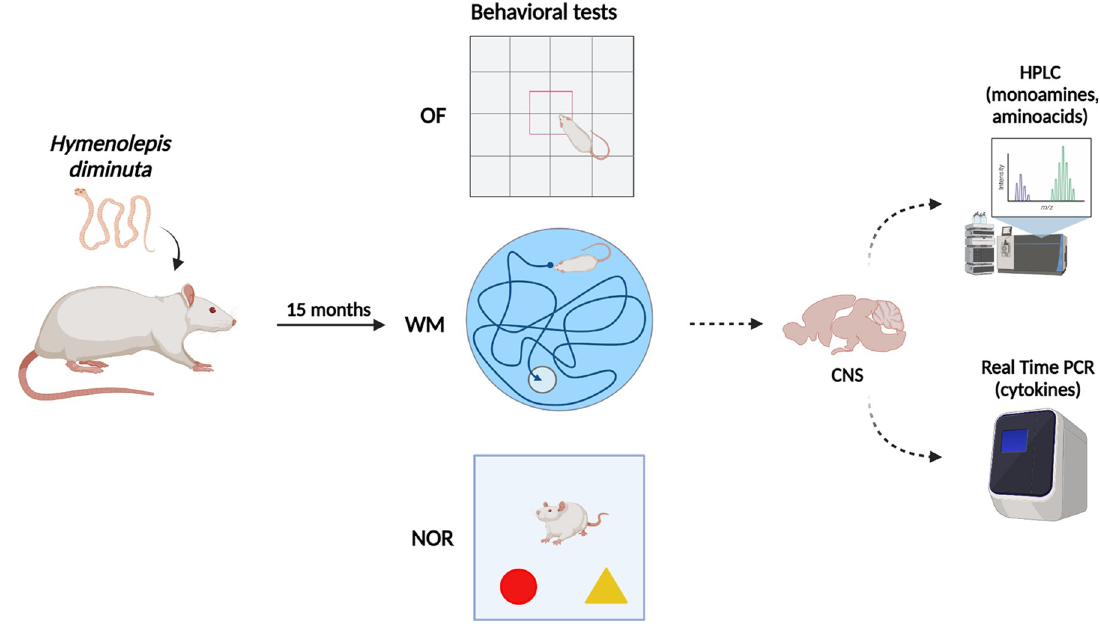
Fig 7. The graphical course of the experiment (created with BioRender.com). 15 months after the tapeworm infection, the animals were subjected to behavioral tests, after which the biochemical changes in the structures of the CNS were analyzed using HPLC and